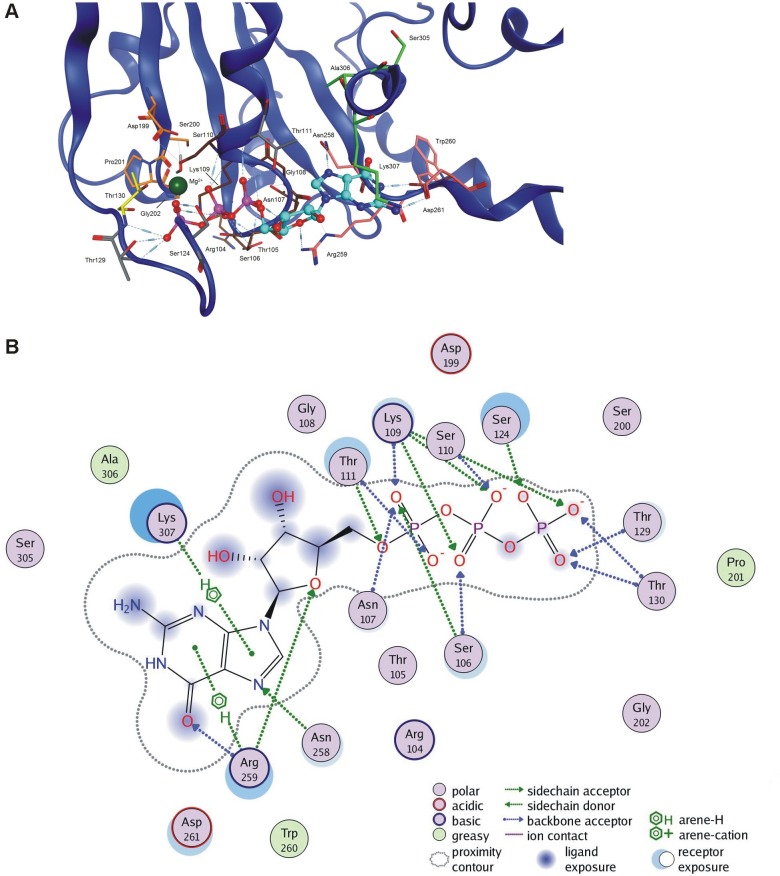
MFN2 GTP binding site and interactions.A. 3D structure of GTPase pocket with GTP ligand present. Oxygen atoms depicted in red, nitrogen in blue, phosphorus in purple. Carbon colors represent specific regions: G1 (brown), G2 (yellow), G3 (orange), G4 (mauve), G5 (green) and additional interacting residues (grey). Ligand carbons are cyan-colored. B. 2D scheme of GTP interactions with the MFN2 pocket.